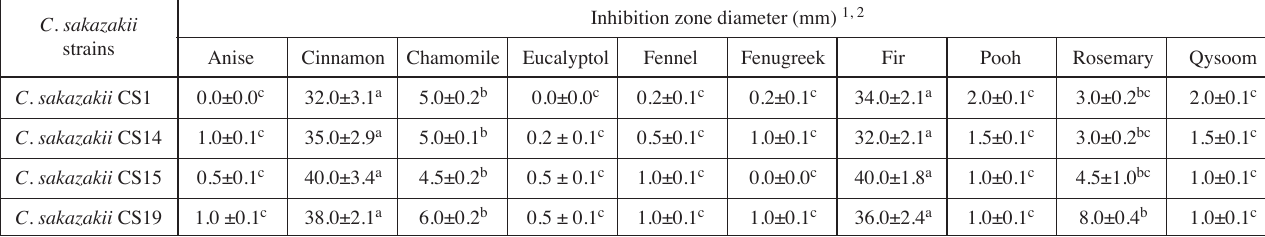
Tab. 1: Antimicrobial activity of 10 medicinal plant essential oils (20 μl/disc) against 4 C. sakazakii strains using disc diffusion method at 37